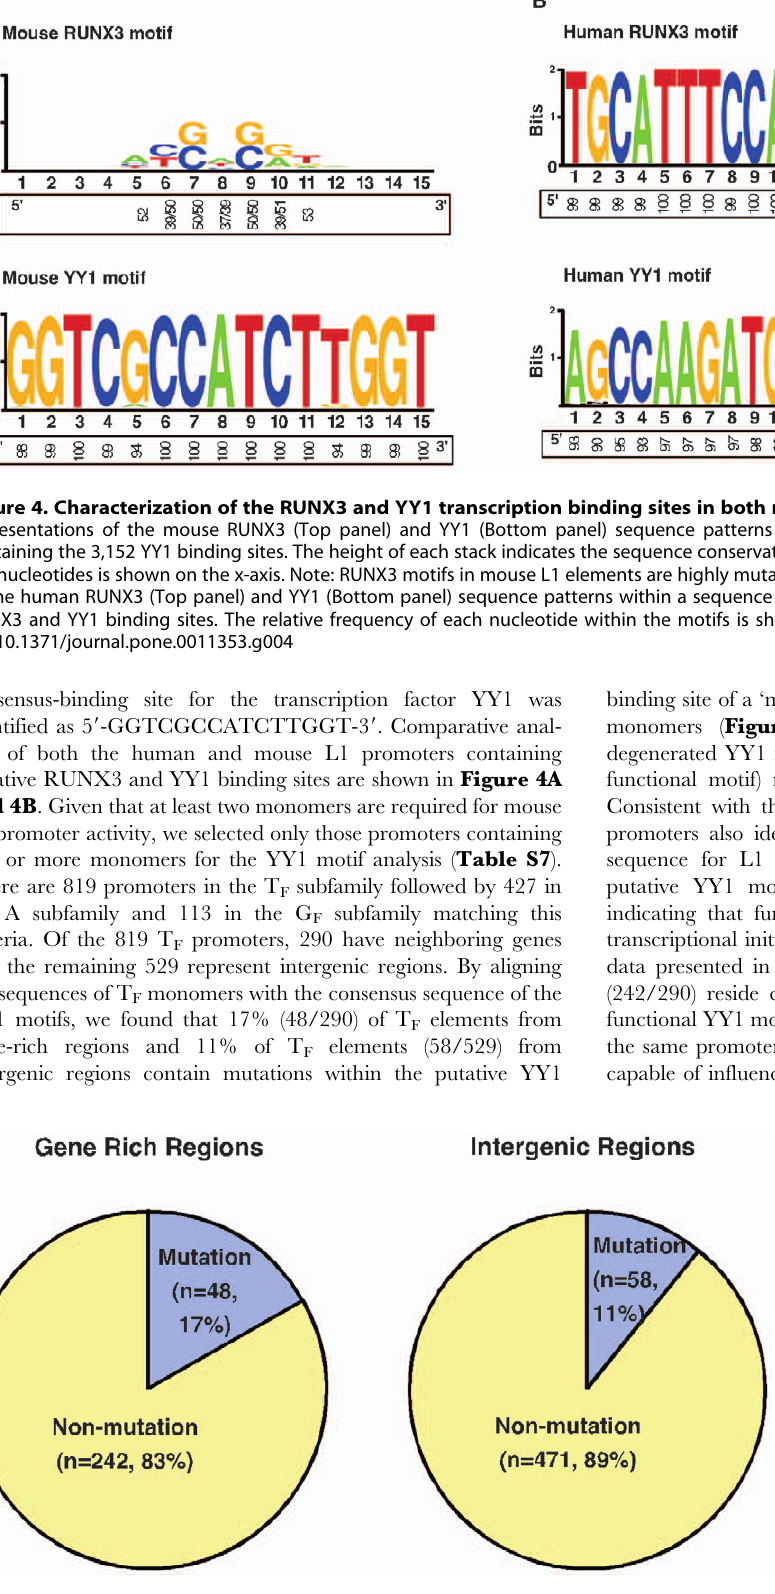
Figure 5. The percentage of mouse L1 promoters found to contain mutations at the YY1 consensus motifs in neighboring genes (left panel; n=290) and intergenic regions (right panel; n =529 L1 elements).